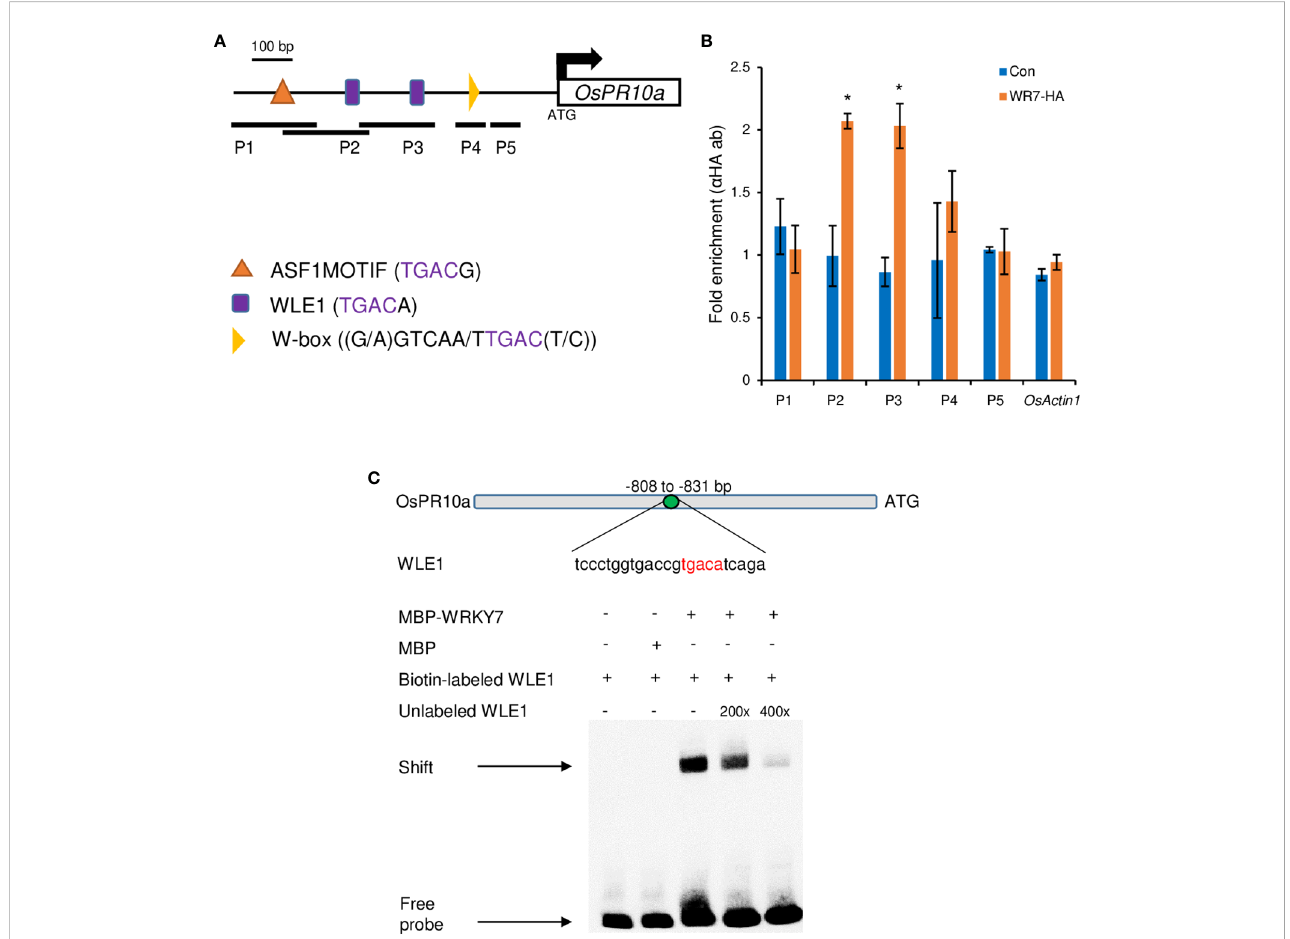
FIGURE 7 ChIP assay on the OsPR10a chromatin region and EMSA experiment. (A) Promoter region of OsPR10a . The black lines under the promoter region indicate the DNA fragment ampli fi ed by RT-PCR. Five pairs of primer set were used in ChIP assay; P1, 849-967 bp from the ATG start codon; P2, 795- 946 bp from the ATG start codon; P3, 647-801 bp from the ATG start codon; P4, 207-289 bp from the ATG start codon; P5, 102-205 bp from the ATG start codon. Scale bar = 100 bp. (B) Chromatin enrichment of the OsPR10a promoter region. Transgenic plants expressing OsWRKY7-HA were used for the ChIP assay. Error bars indicate standard deviations; n = 2. Statistical signi fi cance is indicated by *(P < 0.05). (C) EMSA experiment using the sequence that contains WLE1 element on the promoter of OsPR10a . Biotin-labeled probe WLE1 without MBP-OsWRKY7 protein and biotin-labeled WLE1 with MBP protein were used as negative control. Excess unlabeled WLE1 was used as